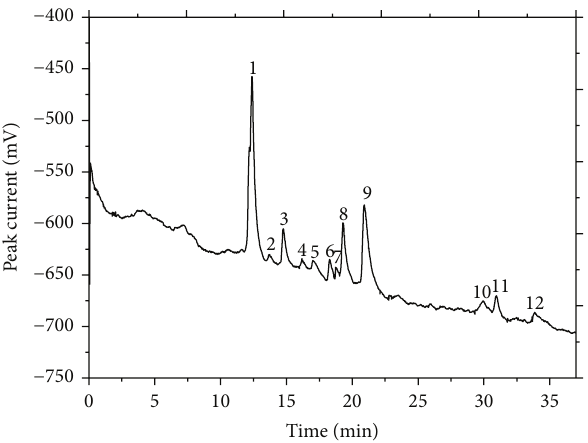
Figure 2: Standard fingerprint for chrysanthemum buds obtained from CE with the copper working electrode. Peak 8: glucose; Peak 11: fructose. Working potential: 0.67 V (versus SCE); separation buffer: Na 2 B 4 O 7 (pH 9.24, 7.63 × 10 −3 g mL −1 ); detection buffer: NaOH (pH 13.0); separation voltage: 20 kV, inject time: 8